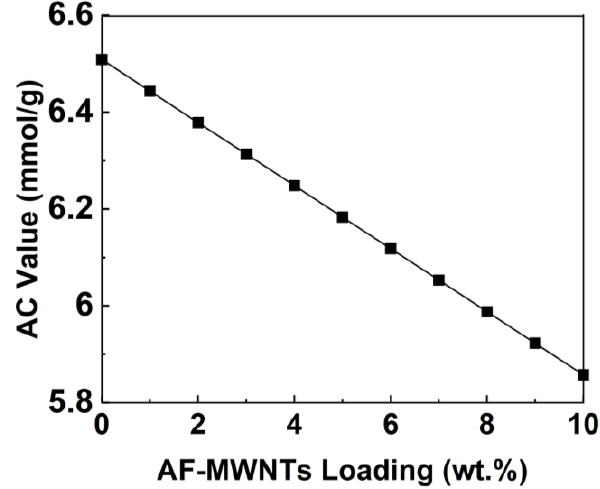
ff erent AF-MWNT